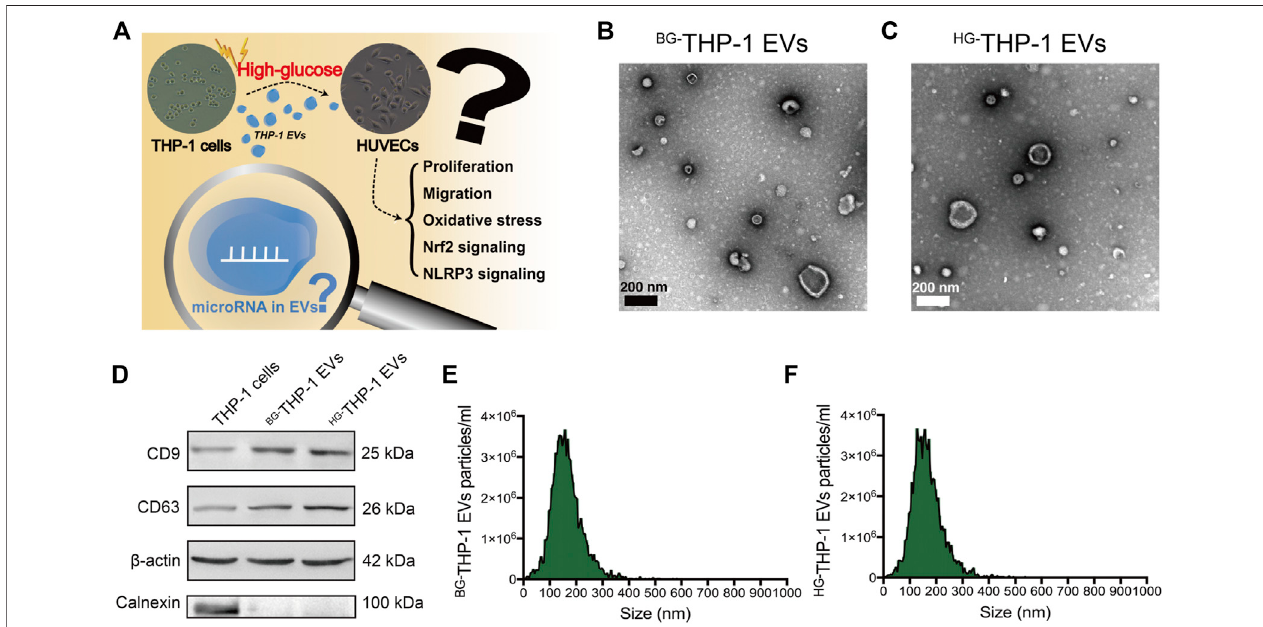
FIGURE 1 | Isolation and identi fi cation of BG- THP-1 EVs and HG- THP-1 EVs (A) Schematic representation of study hypothesis and research question (B,C) Transmission electron microscopy for BG- THP-1 EVs and HG- THP-1 EVs, respectively. Scale bar = 200 nm (D) Western blot of CD9, CD63, Calnexin and β -actin in BG- THP-1 EVs, HG- THP-1 EVs, and THP-1 cells (E,F) Nanoparticle tracking analysis for BG- THP-1 EVs and HG- THP-1 EVs,